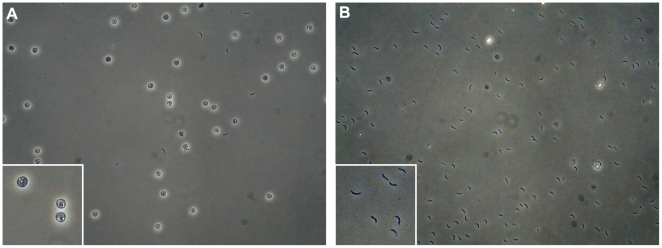
Excystation of Cryptosporidium parvum oocysts.To induce exystation, C. parvum oocysts were incubated for one hour in excystation medium at: A) 25°C; or B) 37°C (see details in the Materials and Methods), and the resulting parasites were observed by phase microscopy at 40× magnification [inset at ∼100×]. Unexcysted oocysts appear as refractile spheres, sporozoites appear as dark crescent shaped cells, and oocyst ghosts appear as dark black spheres (see insets for close-up).